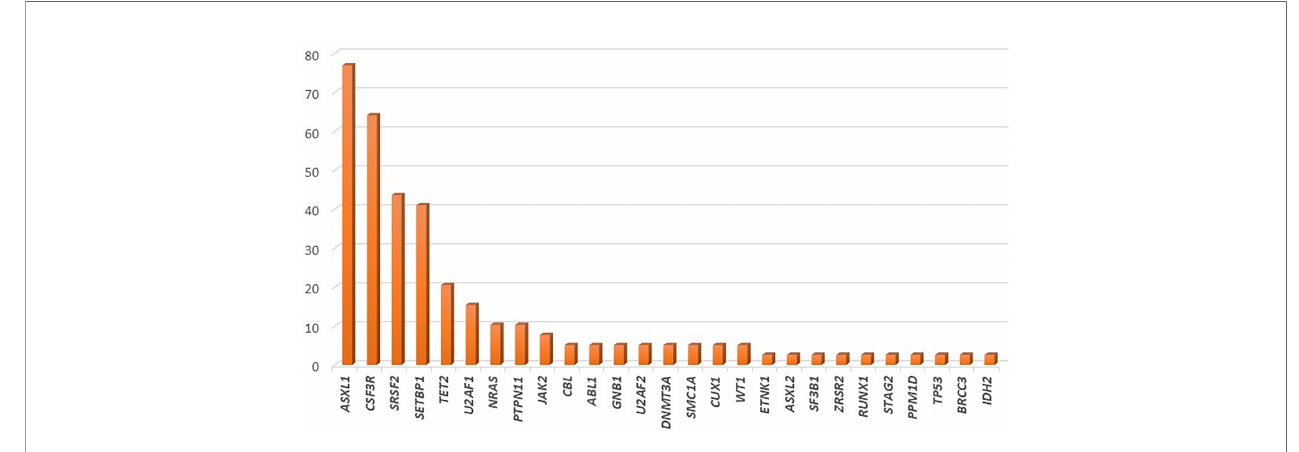
FIGURE 2 | Frequency of gene mutations in chronic neutrophilic leukemia, as demonstrated by application of next generation sequencing in a cohort of